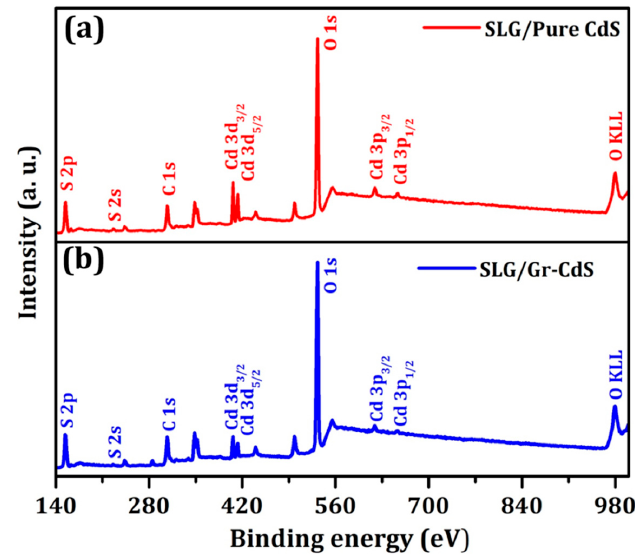
Figure 2. XPS survey spectra of (a) pure CdS NPs and (b) Gr–CdS nanocomposite. Nanomaterials 2020 , 10 , x FOR PEER REVIEW